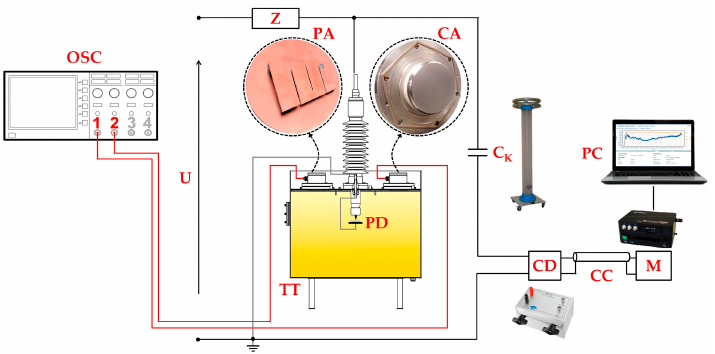
Figure 10. Schematic diagram of the measurement setup in which PD detection sensitivity of the prototype UHF antenna was tested: U = high-voltage supply, Z = short-circuit current limiting resistor, OSC = four-channel oscilloscope, TT = oil-filled transformer tank, PD = electrode system for surface partial discharge generation, PA = prototype meandered PIFA, CA = commercial UHF disk antenna as reference, C K = coupling capacitor, CD = coupling device (measuring impedance), CC = connecting cable, M = conventional partial discharge detector, PC = computer.